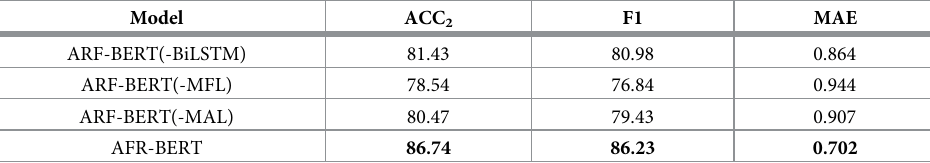
Table 6. Ablation experiments on the CMU-MOSI dataset. Model